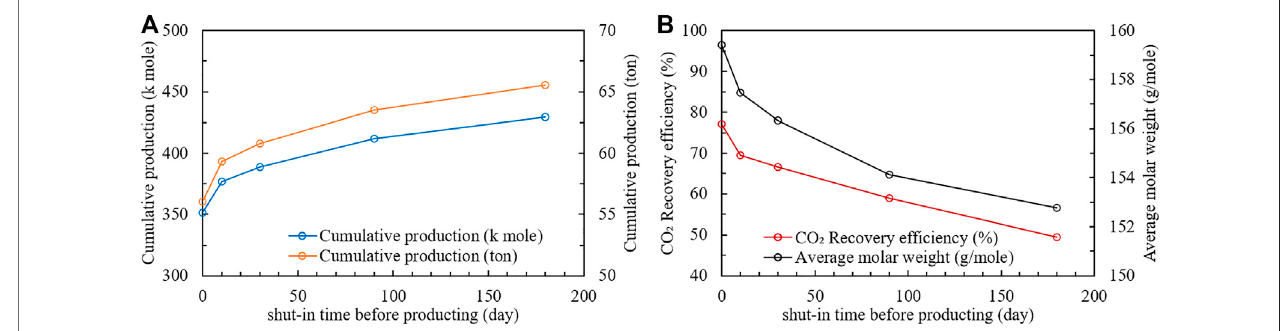
FIGURE 9 | Cumulative production (A) , average molar mass of oil producted and CO 2 recovery ef fi ciency (B) at different shut-in times before producting.